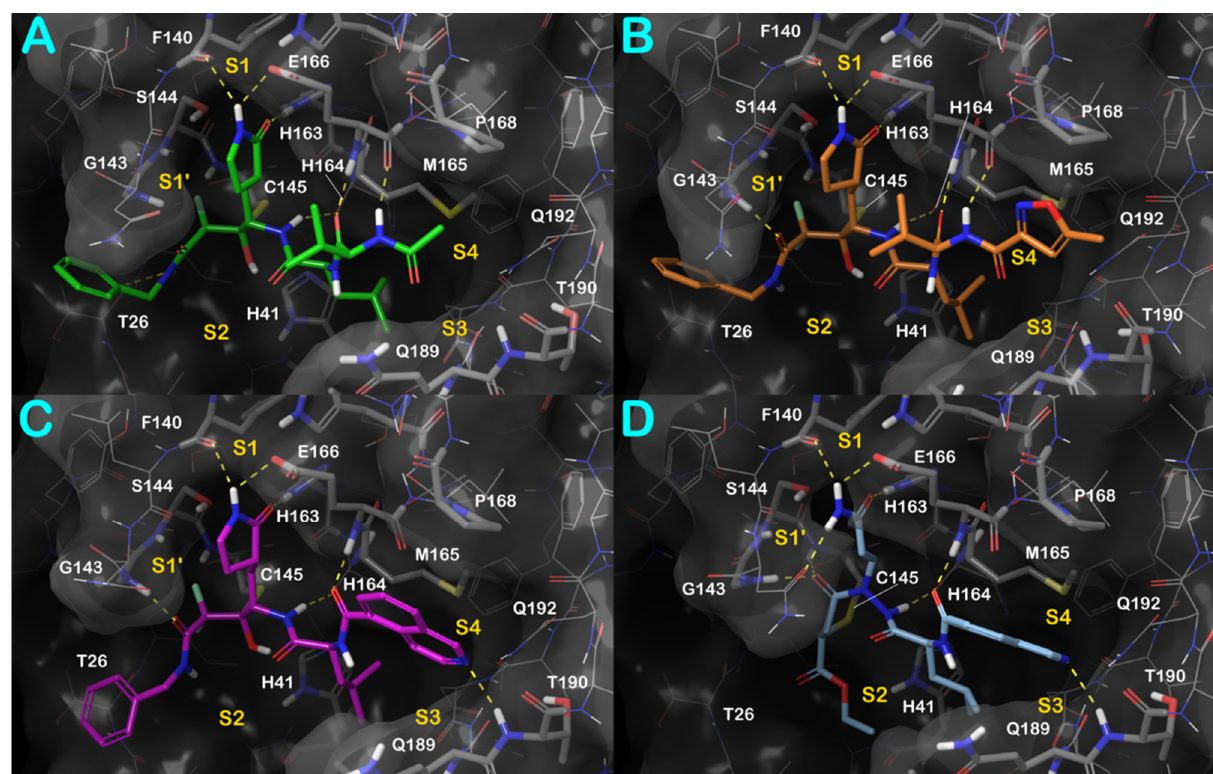
Figure 9. Output regarding the covalent docking investigation considering compounds 4 – 7 (panels A – D , respectively). Key interacting residues from different regions are represented by sticks and labeled. H-bonds are represented as yellow dotted lines. Pictures were generated by Maestro (Maestro, Schrödinger LLC, release 2020-3).